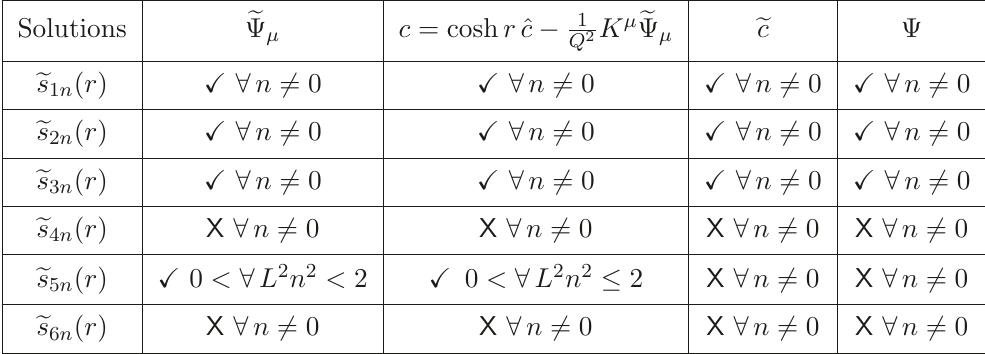
, the variation of the 4